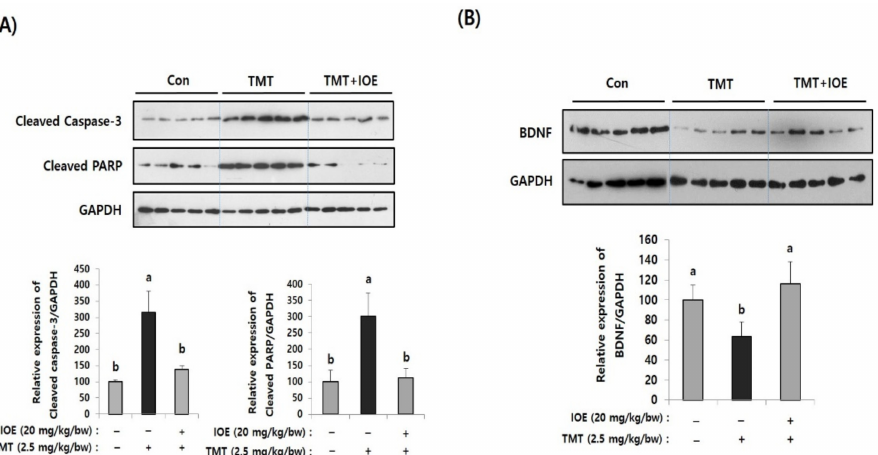
Figure 3. TMT-induced apoptosis in mouse brains was attenuated by oral administration of IOE. Expression of cleaved caspase-3 and cleaved poly (ADP-ribose) polymerase (PARP) ( A ) and brain- derived neurotrophic factor (BDNF) ( B ) in brain tissues of all animal groups were investigated by Western blotting ( n = 5) ( A ). Expressions levels of each gene were estimated by measuring the intensity of each band by using the ImageJ program and were normalized to that of glyceraldehyde 3-phosphate dehydrogenase (GAPDH) and tabulated. Data shown are means ± SD. Con: control (non-treated). a: significant differences ( p < 0.05) when compared with b.